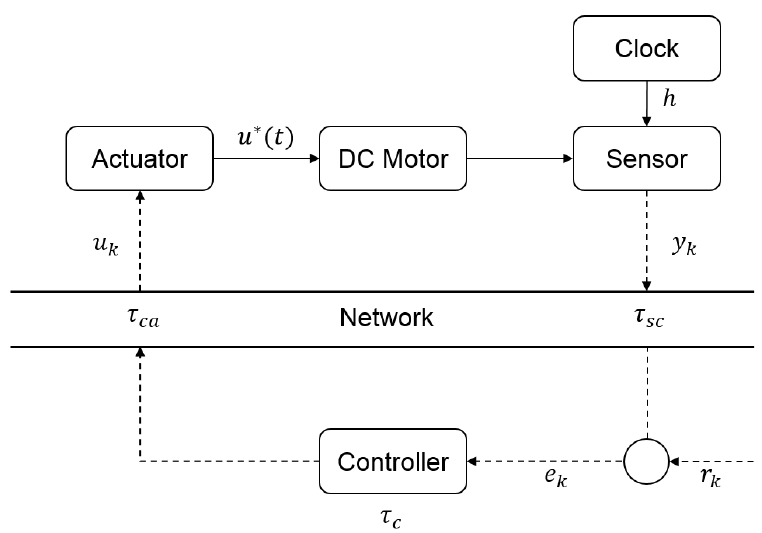
Figure 2. Closed-loop control of control rod